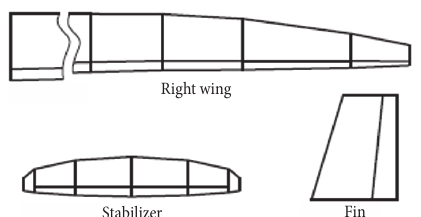
Fig. 5. Aerodynamic models of sailplane lifting